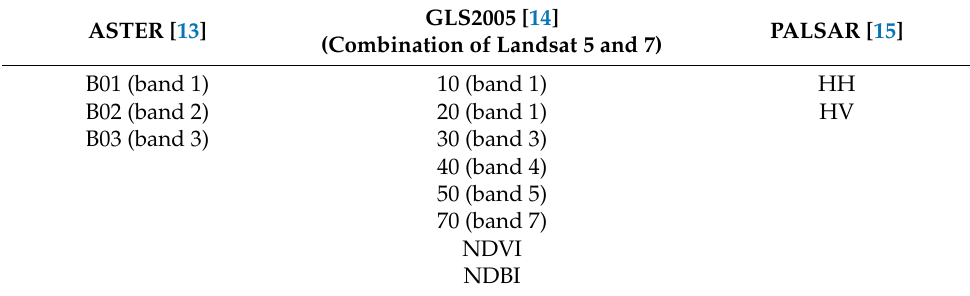
Figure 1. Flow chart of the method for adding spatial uniformity information to the validation data. Table 1. List of satellite data downloaded from GEE.